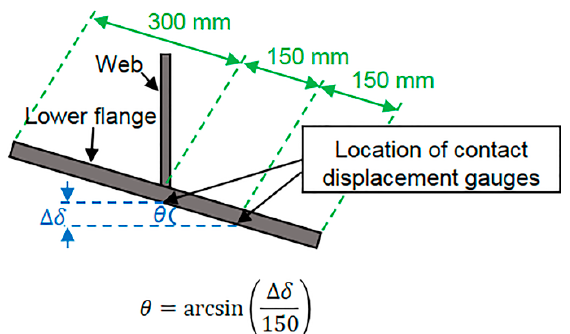
Figure 5. Rotation angle displacement using two contact displacement gauges.